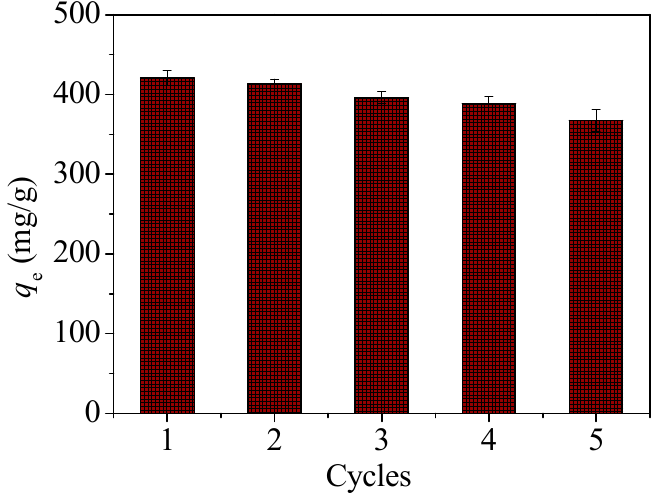
Figure 16. Adsorption and regeneration cycles of CoFe 2 O 4 @SiO 2 -Ppy.